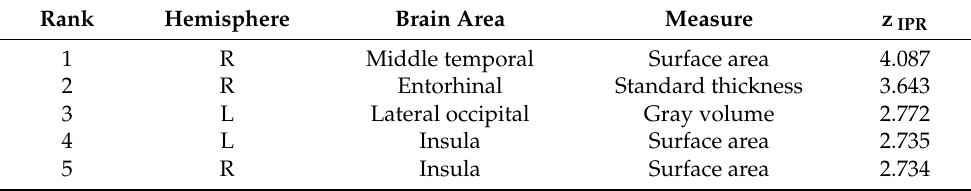
Table 5. Top-ranking brain features of inverse participation ratio (IPR) (Cluster III).